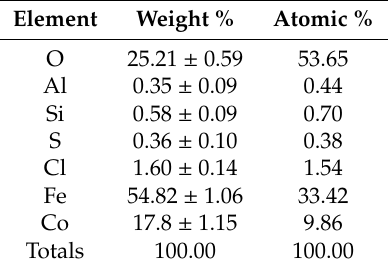
Table 2. Quantitative results of the weight and atomic concentration of selected elements on the basis of EDX presented in Figure 5.